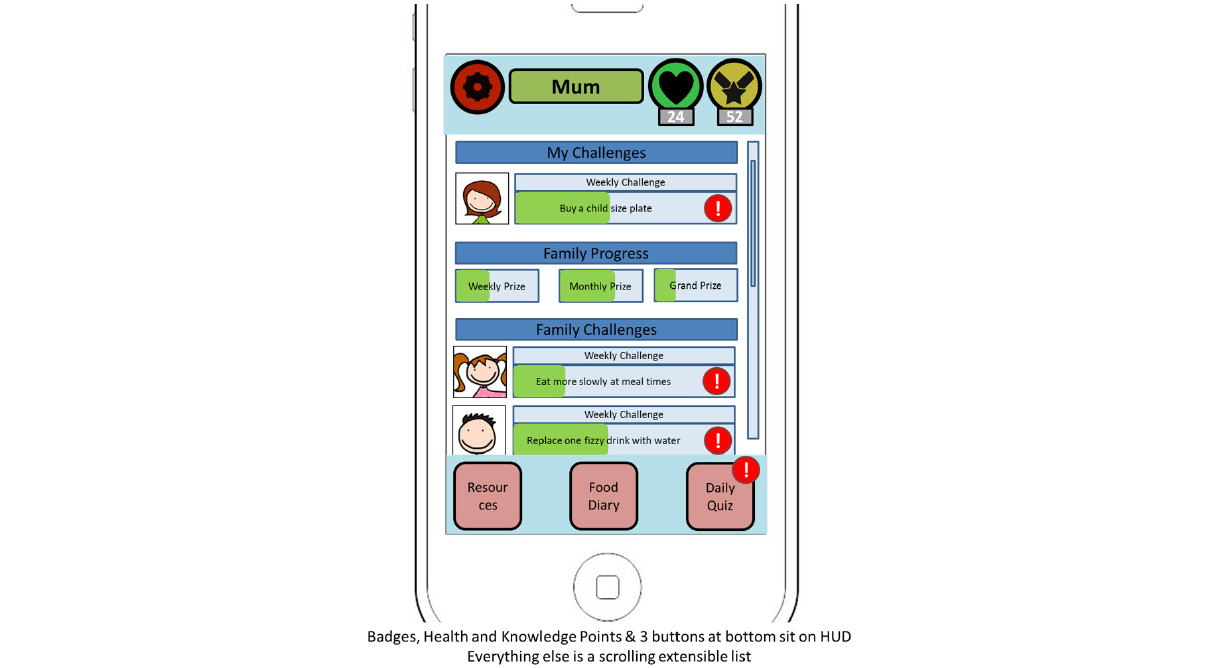
Figure 4. Interactive mock-up of homescreen.